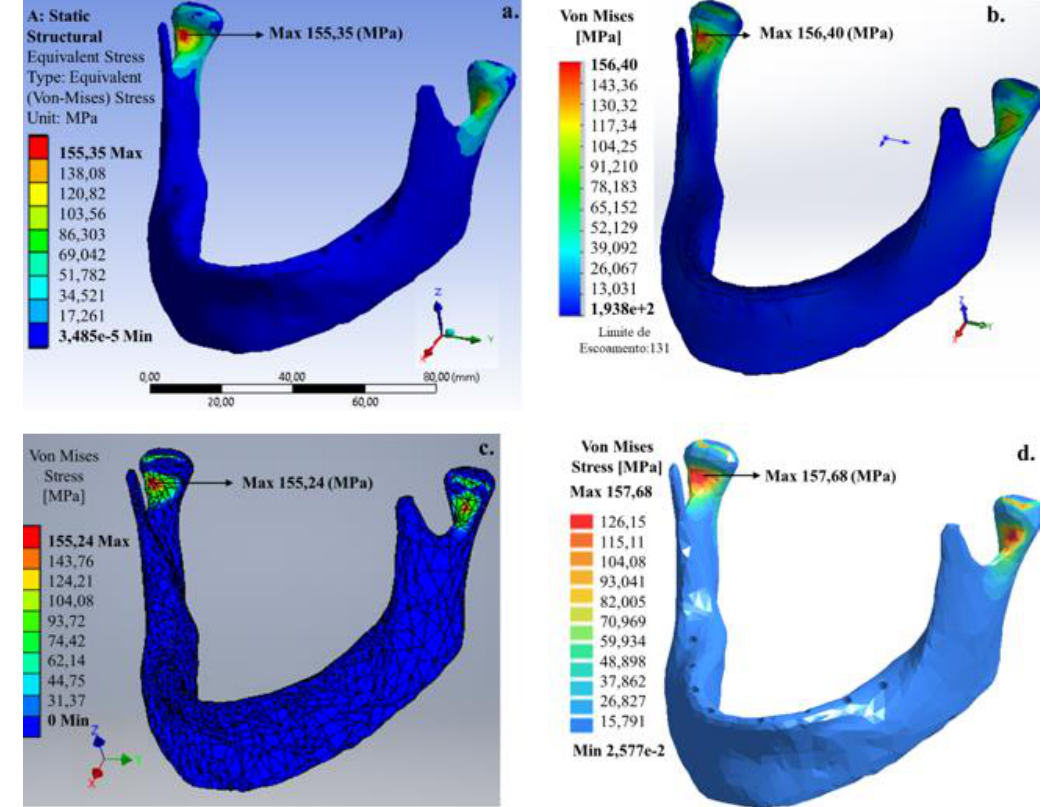
Figure 6. Von Mises stress distribution in the mandible applying 200 N load on the total area of the lower dental arch: ( a ) Ansys ® , ( b ) SolidWorks ® , ( c ) Inventor ® and ( d ) SimSolid ® software. Table 3. Results of the von Mises stress and the percentage error between the software Ansys ® , SolidWorks ® and Inventor ® compared to the software SimSolid ®